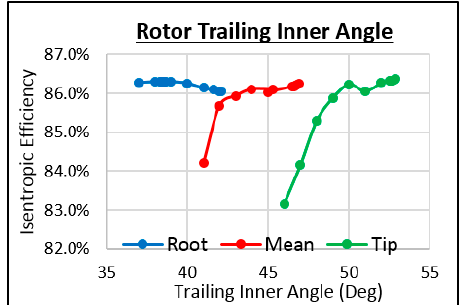
Figure 36. Study of the rotor trailing inner angle.